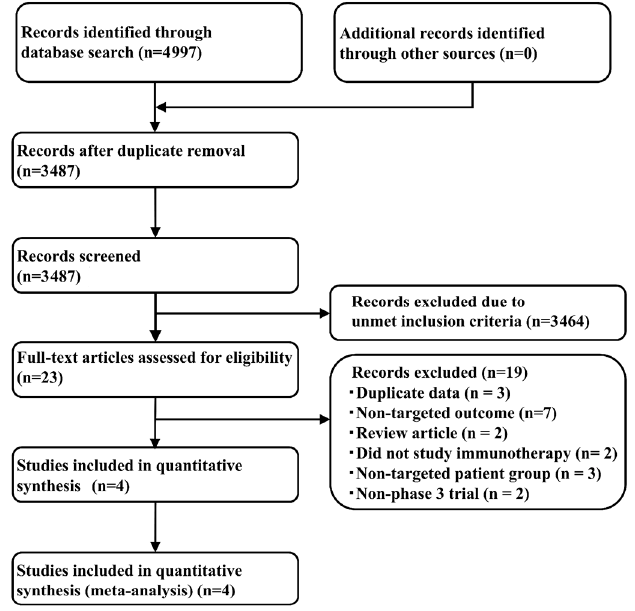
Figure 1. Flow diagram of the study selection process. RCT, randomized controlled trial. Table 1. Key inclusion criteria of the included